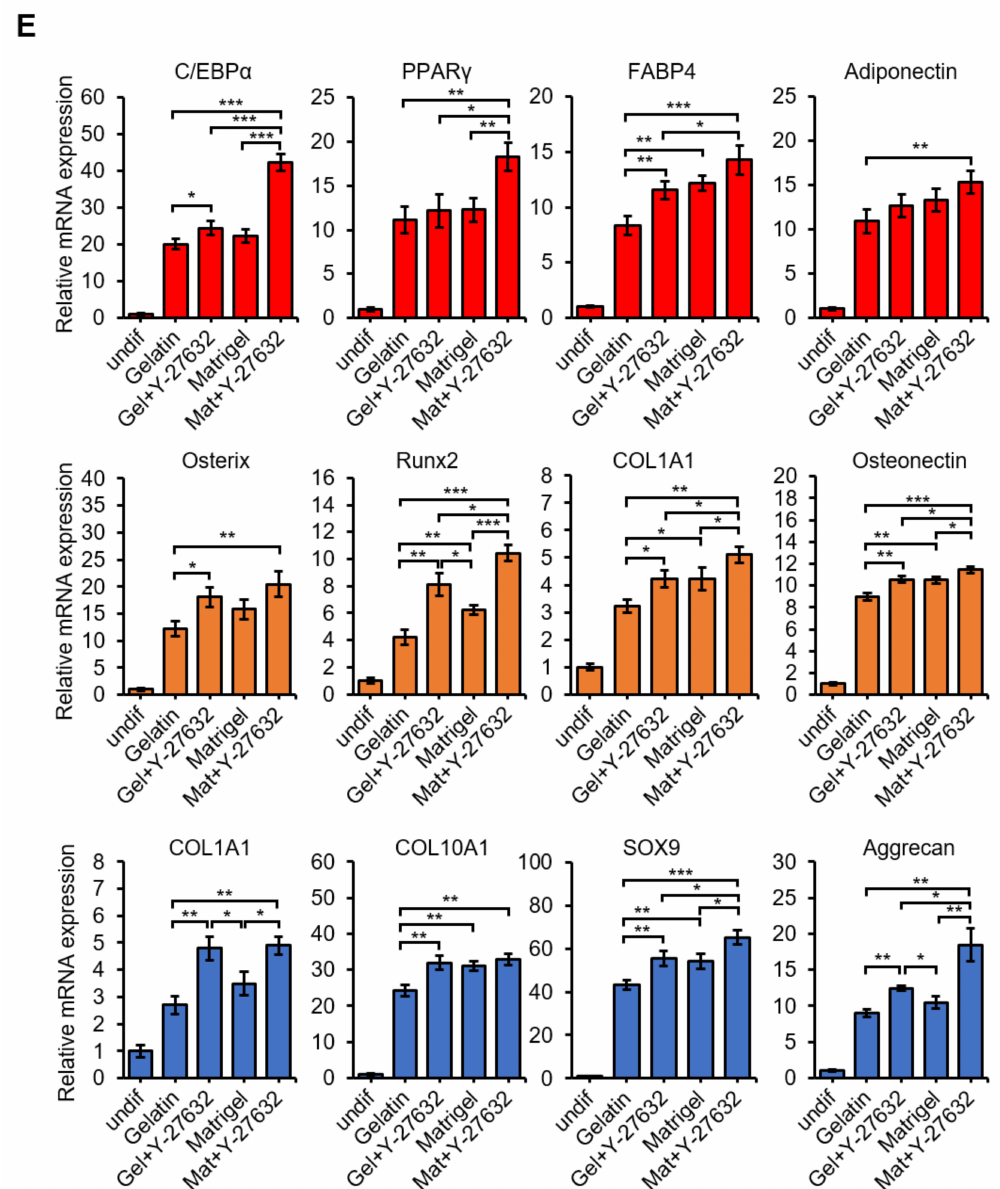
Figure 4. TheeffectofY-27632andMatrigelintheadipogenic, osteogenic, andchondrogenicdifferentiation of USCs. ( A ) Schematic of the USC differentiation procedure with gelatin and Matrigel. ( B ) Differentiation properties of USCs. Oil red O staining for adipogenesis, Alizarin red S staining for osteogenesis, and Alcian blue staining for chondrogenesis. Scale bar: 50 µ m. ( C ) Relative staining area of Oil red O, Alizarin red S and Alcian blue with gelatin only data set to 1. ( D ) Relative ratio of stained to unstained cell number of Oil red O, Alizarin red S and Alcian blue. The ratio of gelatin control group was set to 1 for all graphs. ( E ) mRNA expression profiles of USCs differentiated to adipogenic, osteogenic, and chondrogenic cells. Adipogenic differentiation markers: C / EBP α , PPAR γ , FABP4, and adiponectin. Osteogenic differentiation markers: Osterix, Runx2, COL1A1, and osteonectin. Chondrogenic differentiation markers: COL1A1, COL10A1, SOX9, and aggrecan. The data are presented as fold changes compared with the undif. n = 3 biological samples. (* p < 0.05, ** p < 0.01, *** p <